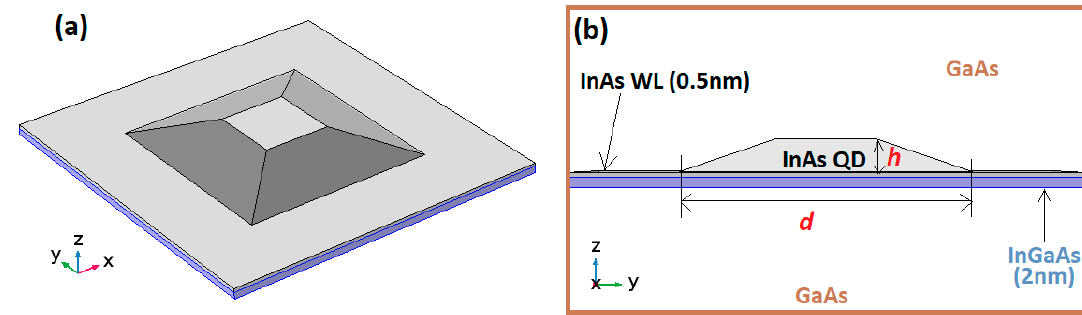
Figure 6. Schematics of the modeled QD structure: ( a ) 3D view; and ( b ) cross ‐ sectional view showing the layers thicknesses and QD dimensions. h and d are the QDs’ height and base side length, respectively.